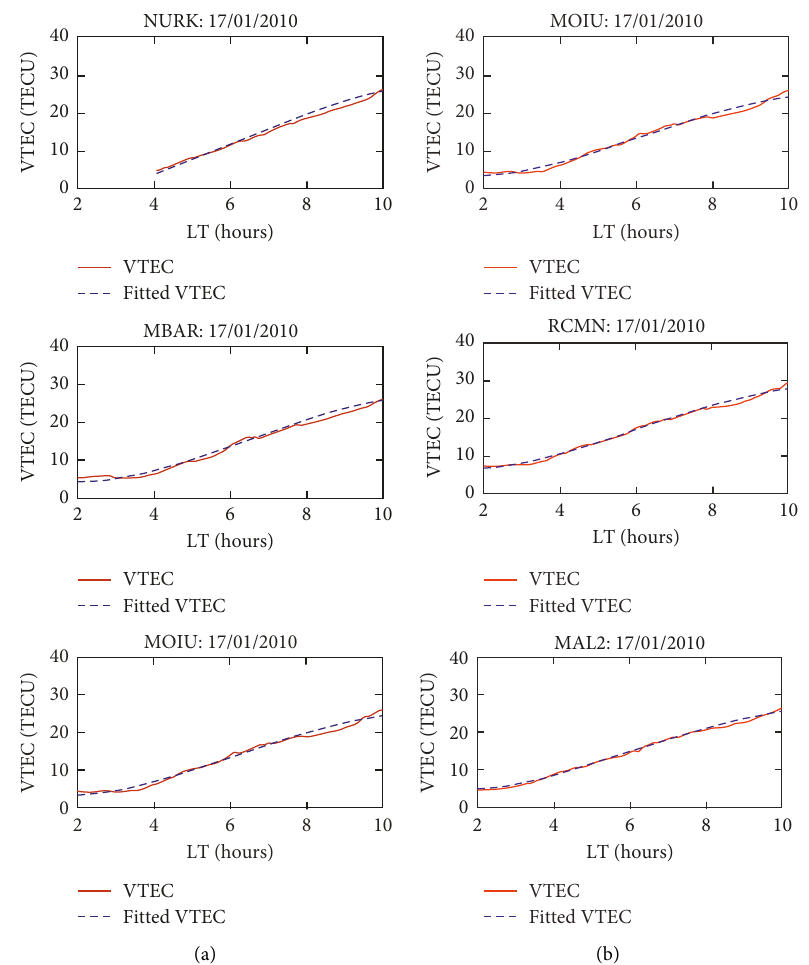
Figure 10: VTEC and fitted VTEC against local time (LT) across (a) NURK-MBAR-MOIU and (b) MOIU-RCMN-MAL2 GPS array on 17 th January